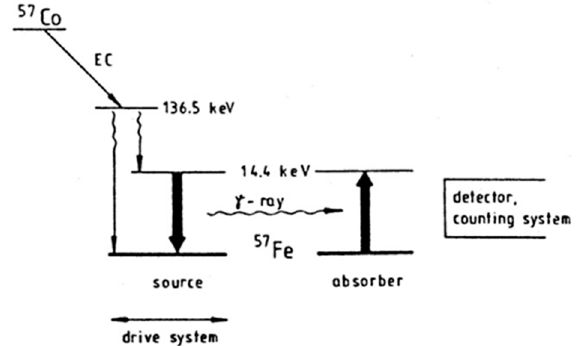
Figure 8. Schematic representation of a typical Mössbauer experimental arrangement. Reproduced from [27, with permission from World Scientific, 1958.